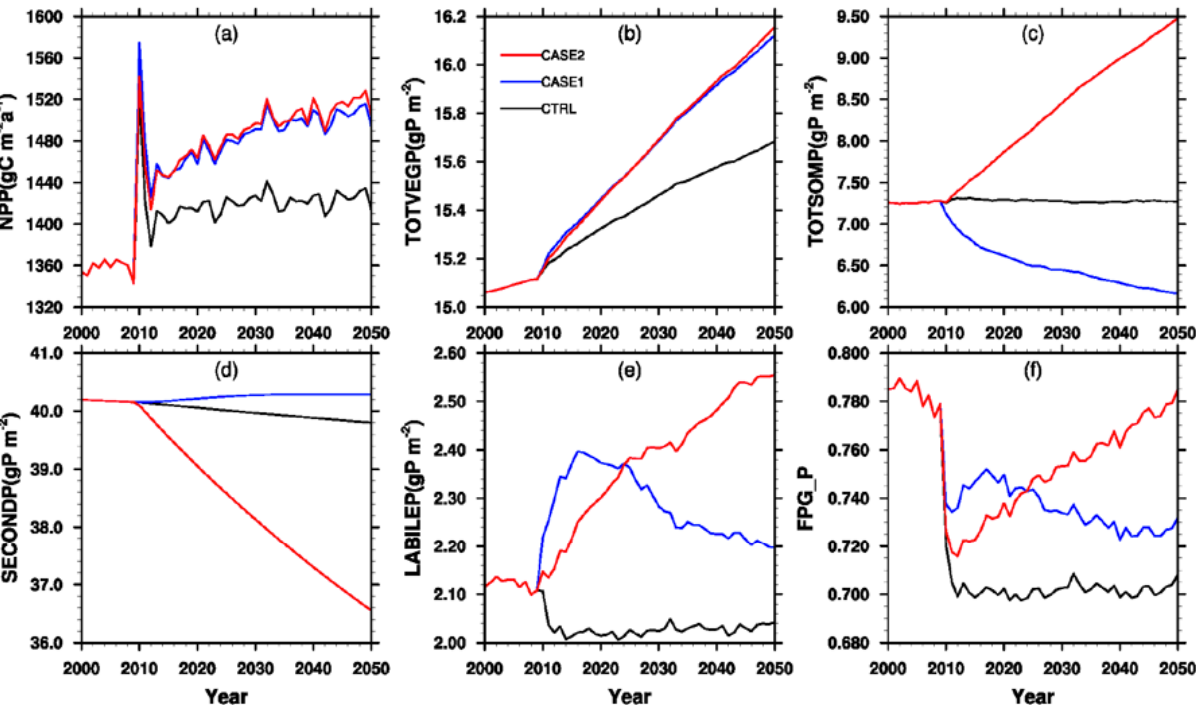
Fig. 7. Simulated time course of (a) net primary production, (b) vegetation P, (c) soil organic P, (d) secondary mineral P ( P sec ) , (e) labile P ( P lab ) , and (f) the degree of P limitation ( f P plant ) for three simulation cases. Control: default parameters (desorption rate and specific biochemical mineralization rate kept unchanged), Case1: enhanced biochemical mineralization (biochemical mineralization rate doubled), Case2: enhanced desorption (desorption rate doubled).